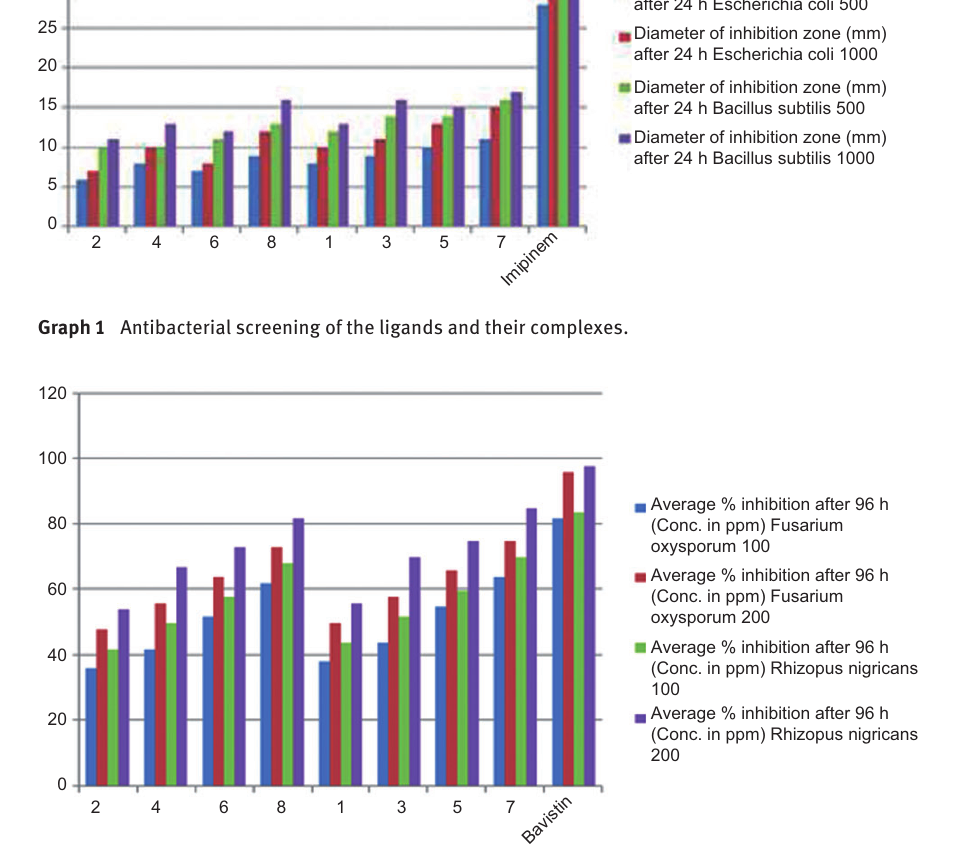
Graph 2 Antifungal screening of the ligands and their complexes.